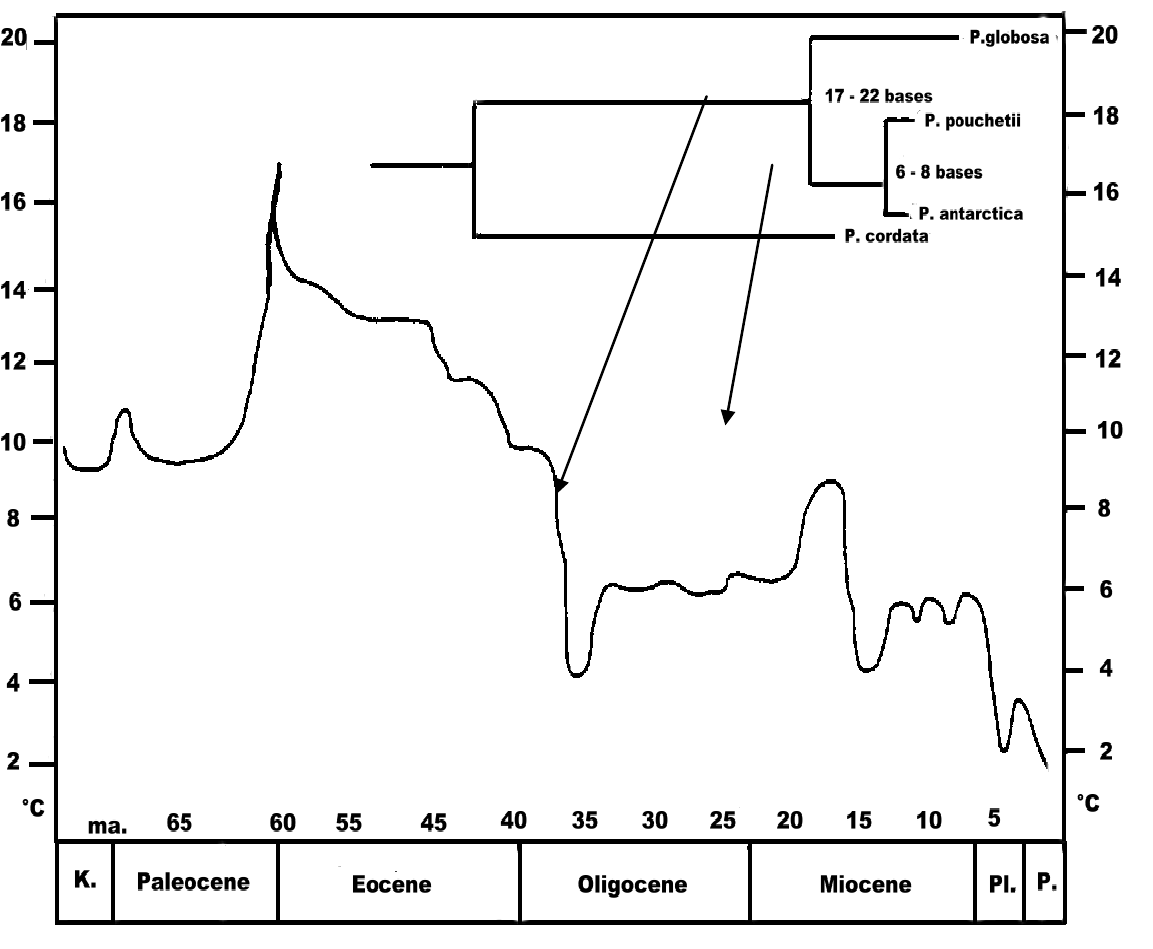
Figure 6. Divergence of Phaeocystis spp.: A molecular tree drawn proportional to time and the temperature of Antarctic surface waters since the Cretaceous, redrawn from Crame [159]. Arrows mark the cooling event that opened the Drake Passage to commence the ACC and the warming event, which allowed Antarctic strains of Phaeocystis to pass the equator to establish themselves into the Arctic, followed by a cooling event, which isolated the two populations allowing them to